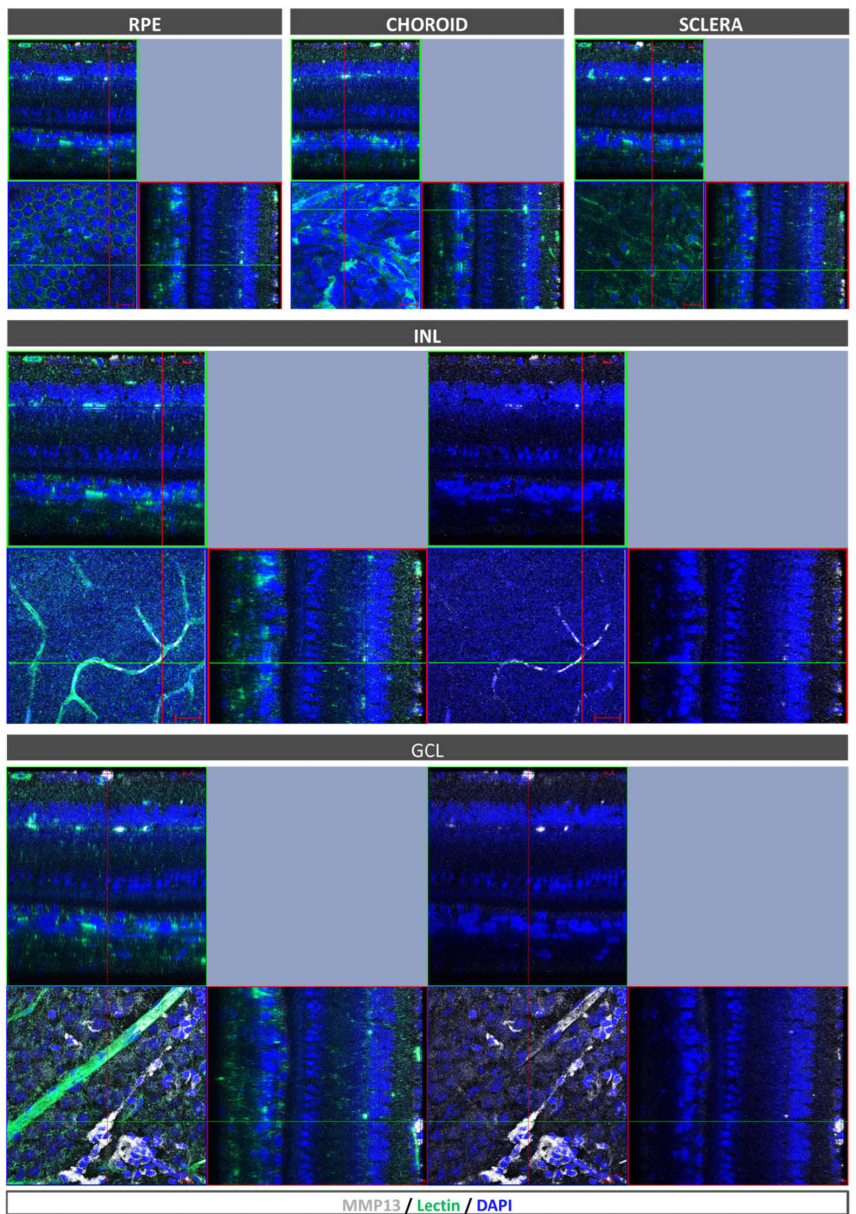
Figure 3. MMP13 characterization in mice posterior pole using immunofluorescence. While no MMP13 expression was observed in the RPE, choroid, or sclera (upper row), the retinal blood